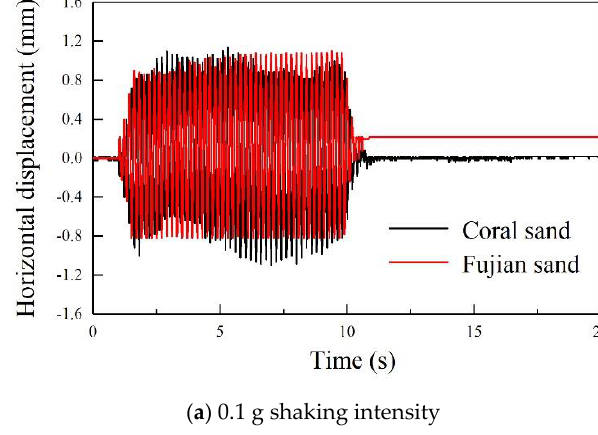
Figure 11. Fourier analysis of white noise: ( a ) coral sand; and, ( b ) Fujian sand.